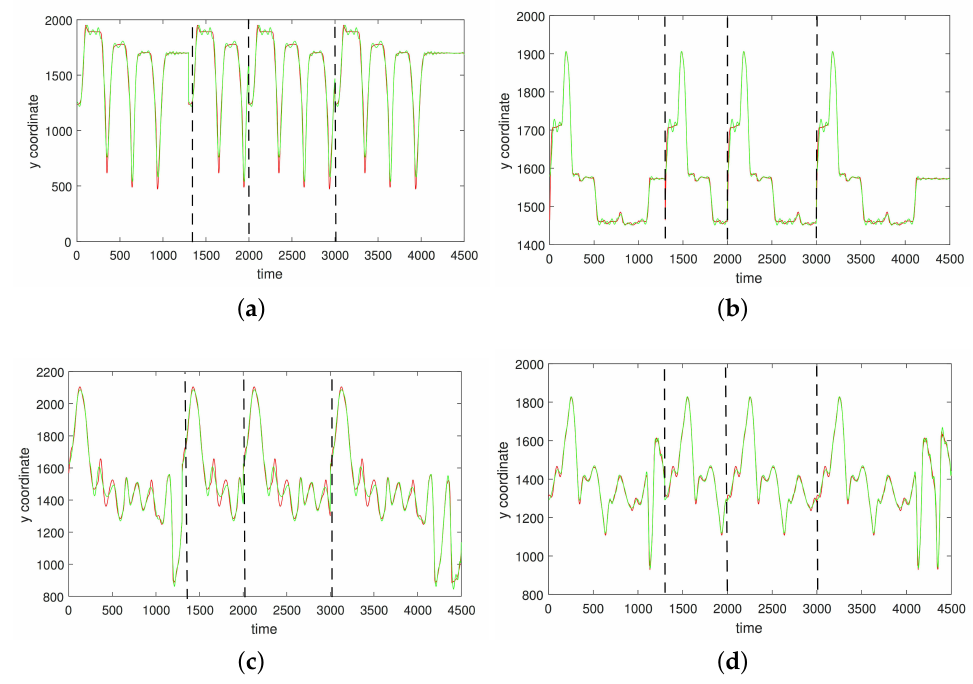
Figure 5. An approximation of y -coordinates by 50 satellites and two centers of motion (CMU 86 Trial 1; sampled at 120Hz). ( a ) Right heel; ( b ) Left heel; ( c ) Right wrist, distal; ( d ) Left wrist, distal. The red curve shows the experimentally observed coordinates and the green curve gives their neural approximations.